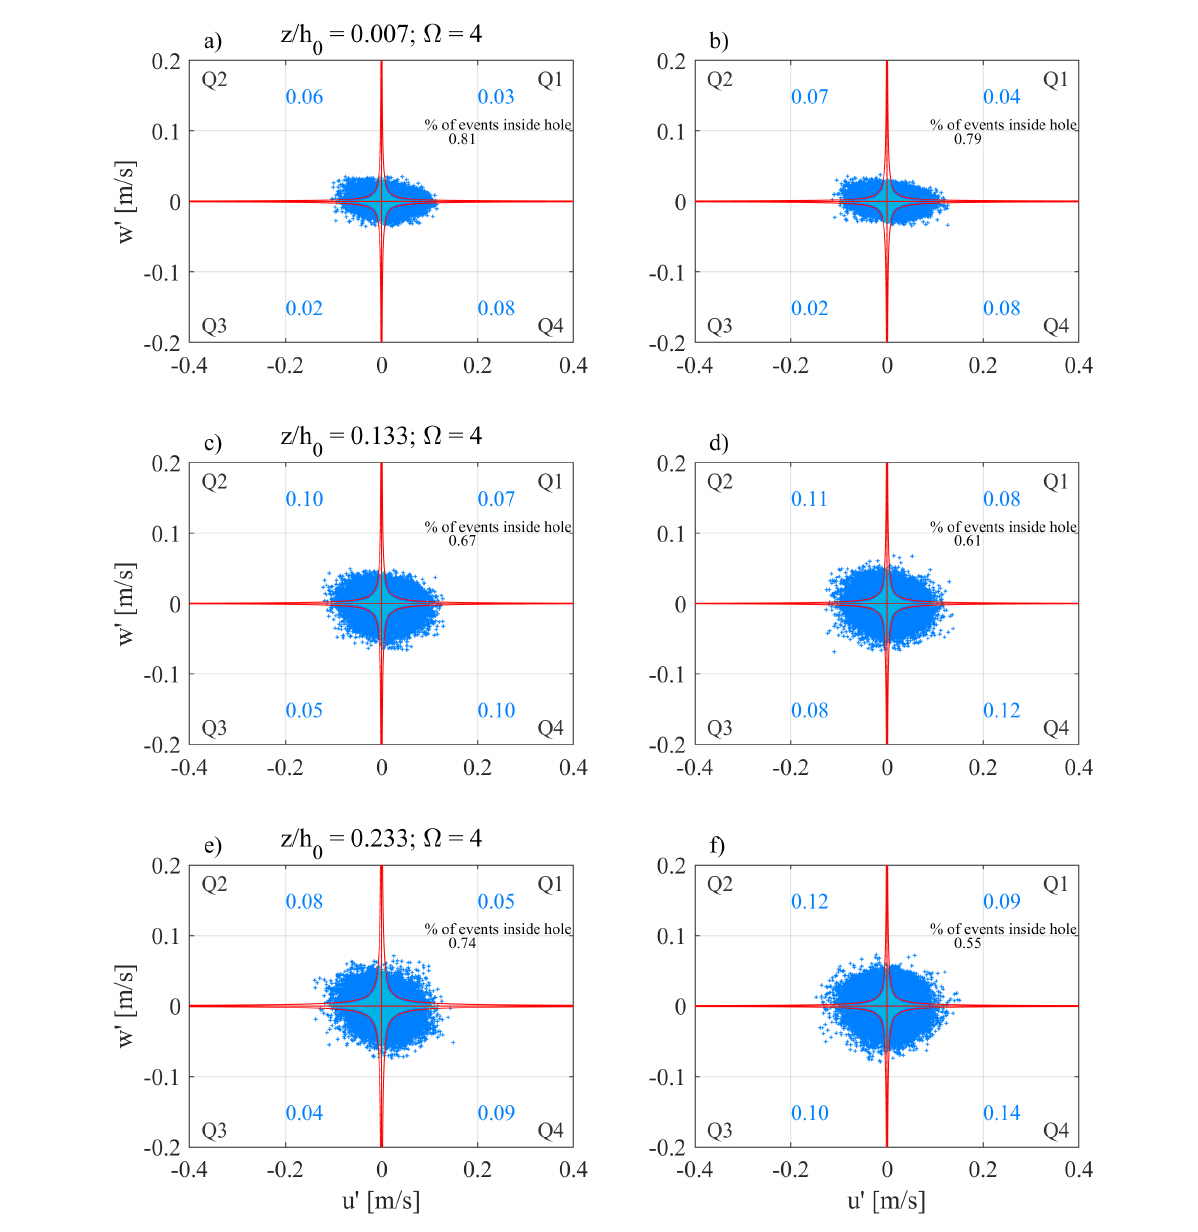
Figure 13. Correlation plots for u (cid:48) and w (cid:48) for test 3 (CO, a , c , e ) and test 9 (WC, b , d , f ), at different distance from bottom: z / h 0 = 0.007 ( a , b ), z / h 0 = 0.133 ( c , d ), z / h 0 = 0.233 ( e , f ). Both tests are at central position and have same mean current velocity U = 0.14 m/s. Hyperbolic hole Ω =